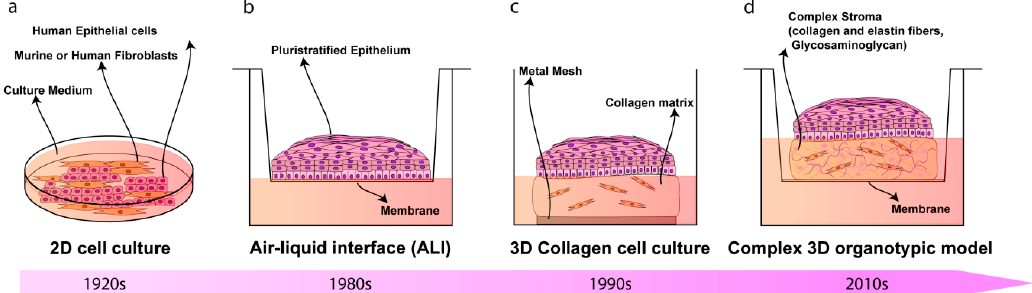
Figure 2. Timeline representing the evolution of in vitro culture systems for the study of HPV-related diseases. ( a ) Two-dimensional (2D) cell mono- or co-culture models have been used since the early 1900s; ( b ) in the 1980s, air-liquid interface (ALI) cultures were developed; these models consist of the epithelial cells seeding onto a semi-permeable membrane, allowing the formation of the epithelial strata; ( c ) three-dimensional (3D) collagen cell culture represented the first 3D model that reconstructs both epithelium and stroma and were developed in 1990s: primary or immortalized cells are cultured for 2–3 weeks onto the fibroblasts-feeder-layer or on collagen matrix populated with fibroblasts, intending to mimic the lamina propria. The epithelial cells, then, are induced to stratify and differentiate; ( d ) complex 3D organotypic models built up from tissue explant-repopulated-matrix, de-epidermized culture or endogenously produced extracellular matrix (ECM) was developed in the 2010s. These models provide a complex ECM with a well-differentiated epithelium that physiologically resembles the native tissue.